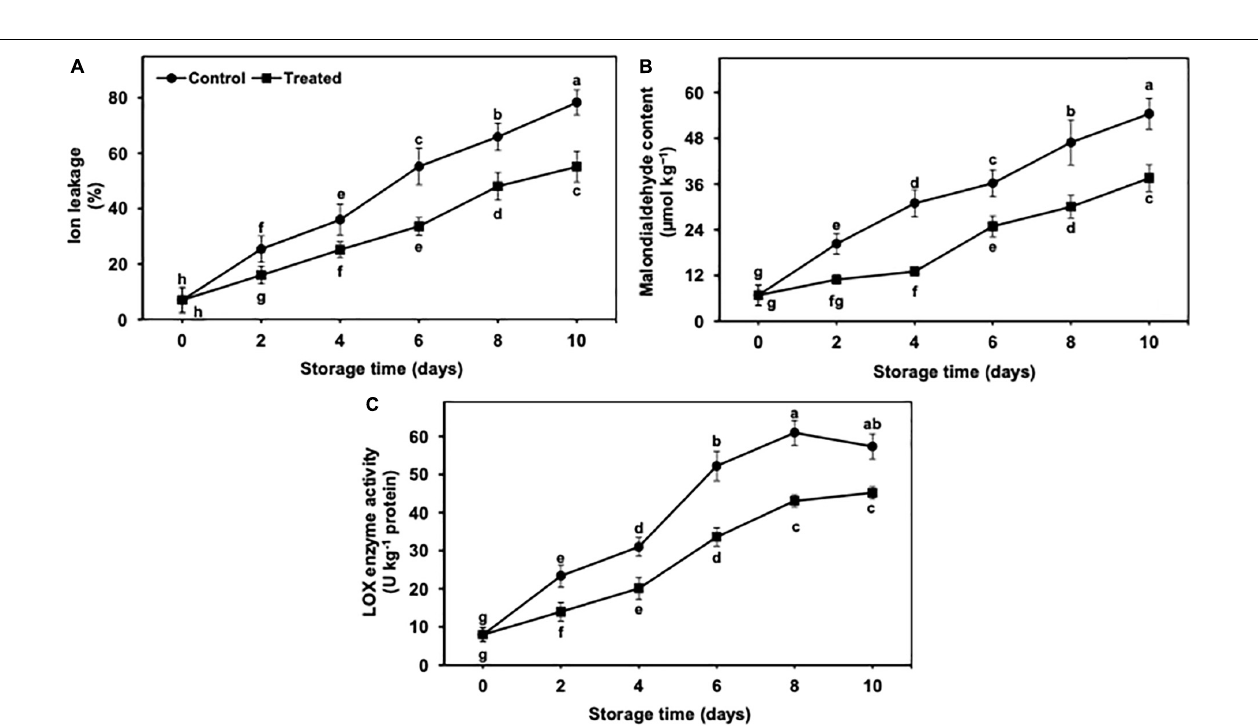
FIGURE 4 | Effect of hydrogen sulfide on ion leakage (A) , malondialdehyde content (B) and LOX enzyme activity (C) in peel of banana fruit. Data are mean of three replications and vertical bars show standard of the means. Different letters show significant difference according to least significant difference test.